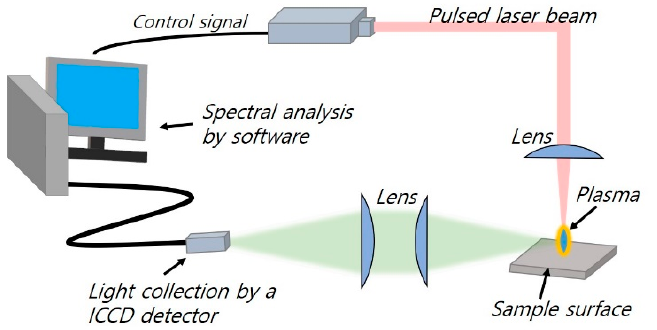
Figure 2. Schematic of LIBS setup.